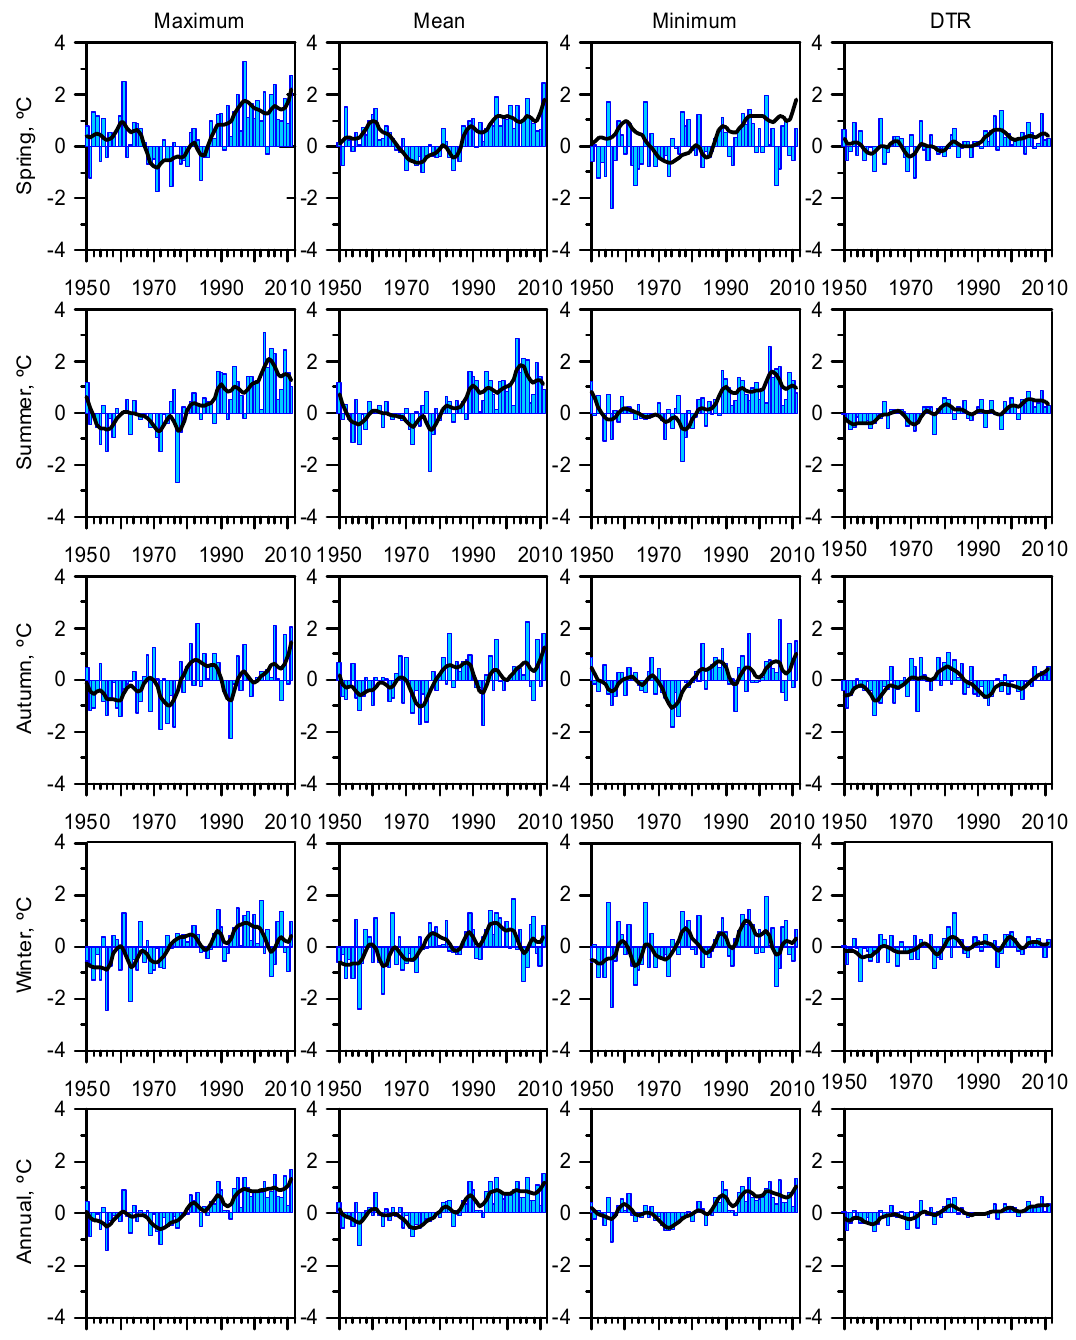
Figure 2. Seasonal and annual anomalies of maximum, mean and minimum temperatures (°C) and DTR time series for the period 1950–2011 shown as light blue bars. Dark blue lines show a low Gaussian filter of 11 years. The anomalies were calculated from the climatic norm of 1961–1990 period.